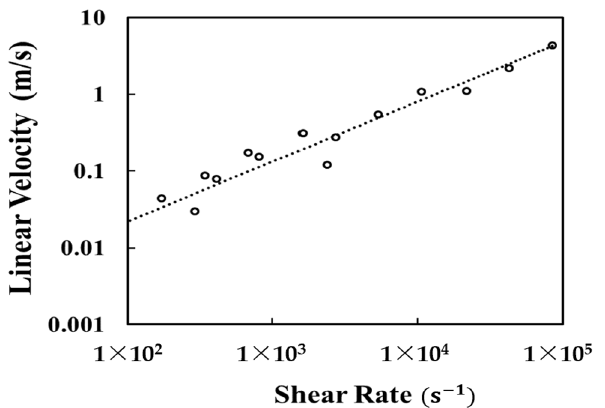
Figure 7. The linear velocity of water vs. various shear rates of PTE.